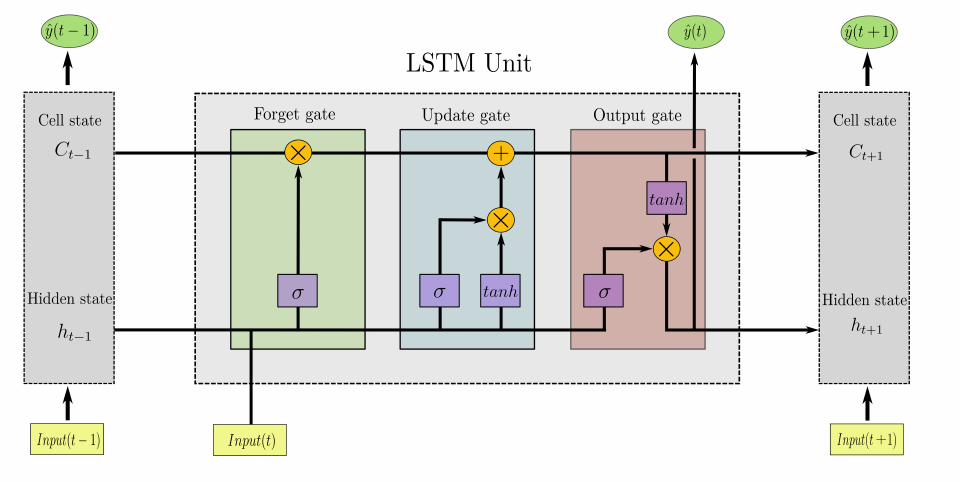
Figure 4. Architecture of an LSTM